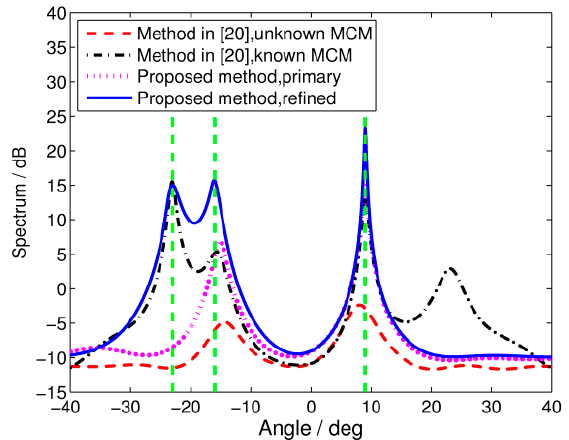
Figure 7. Spatial spectrums of wideband DOA estimation with blind angles. SNR = 5 dB, snapshots = 100.